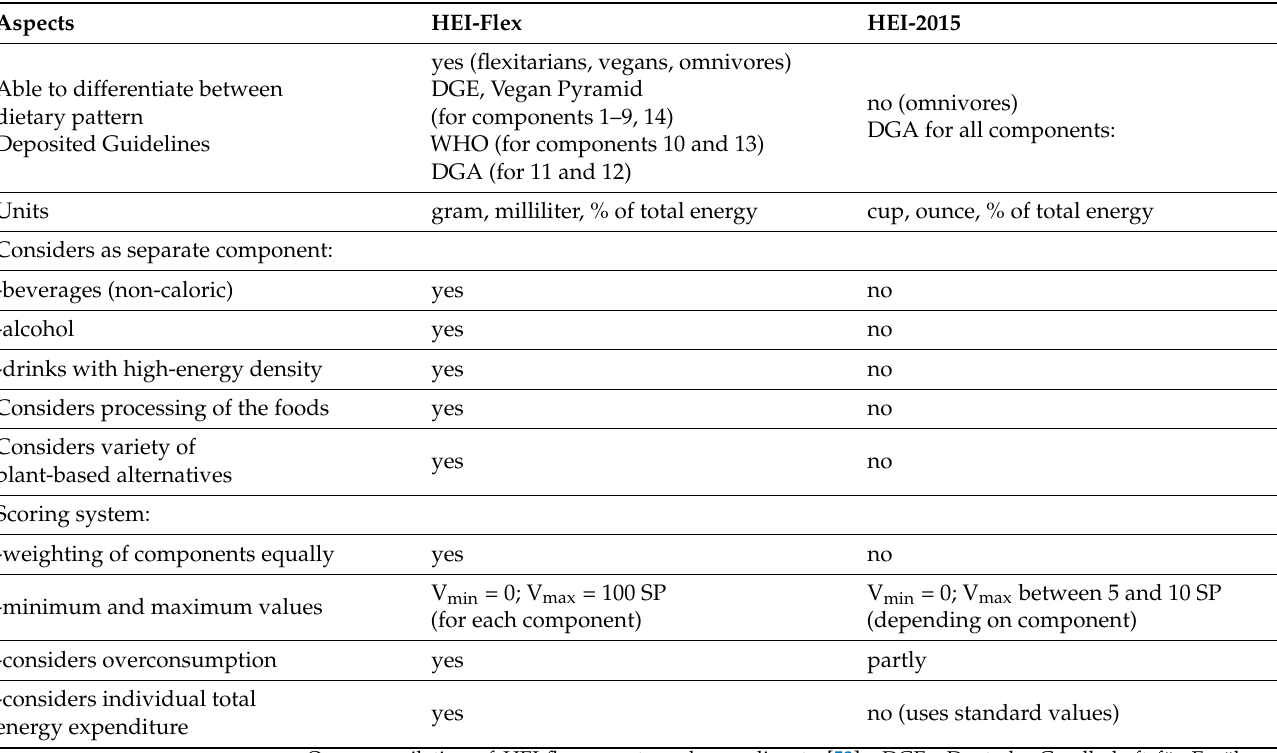
Table A2. Essential similarities and differences of HEI-flex and HEI-2015.